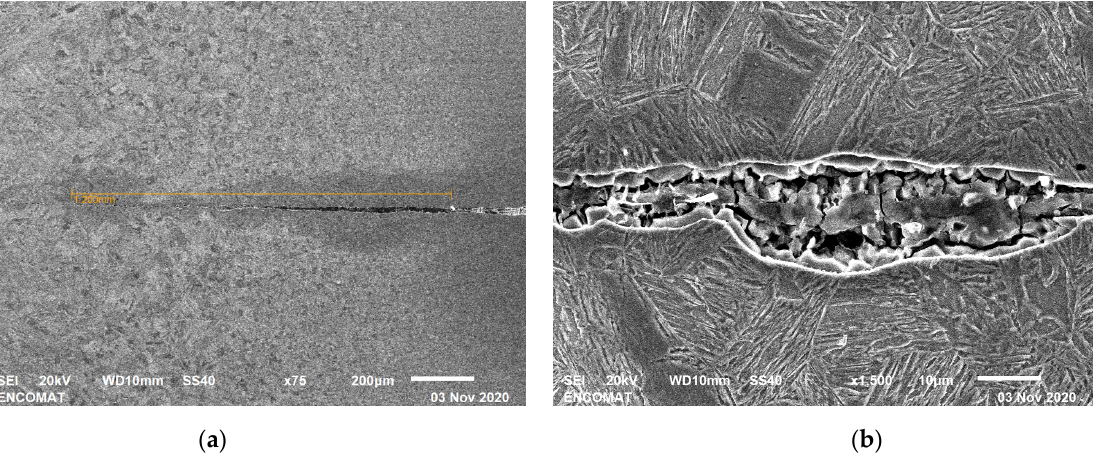
Figure 9. SEM of D min for f = 7000 Hz: ( a ) the interface ( b ) detail of Zn in the interface.